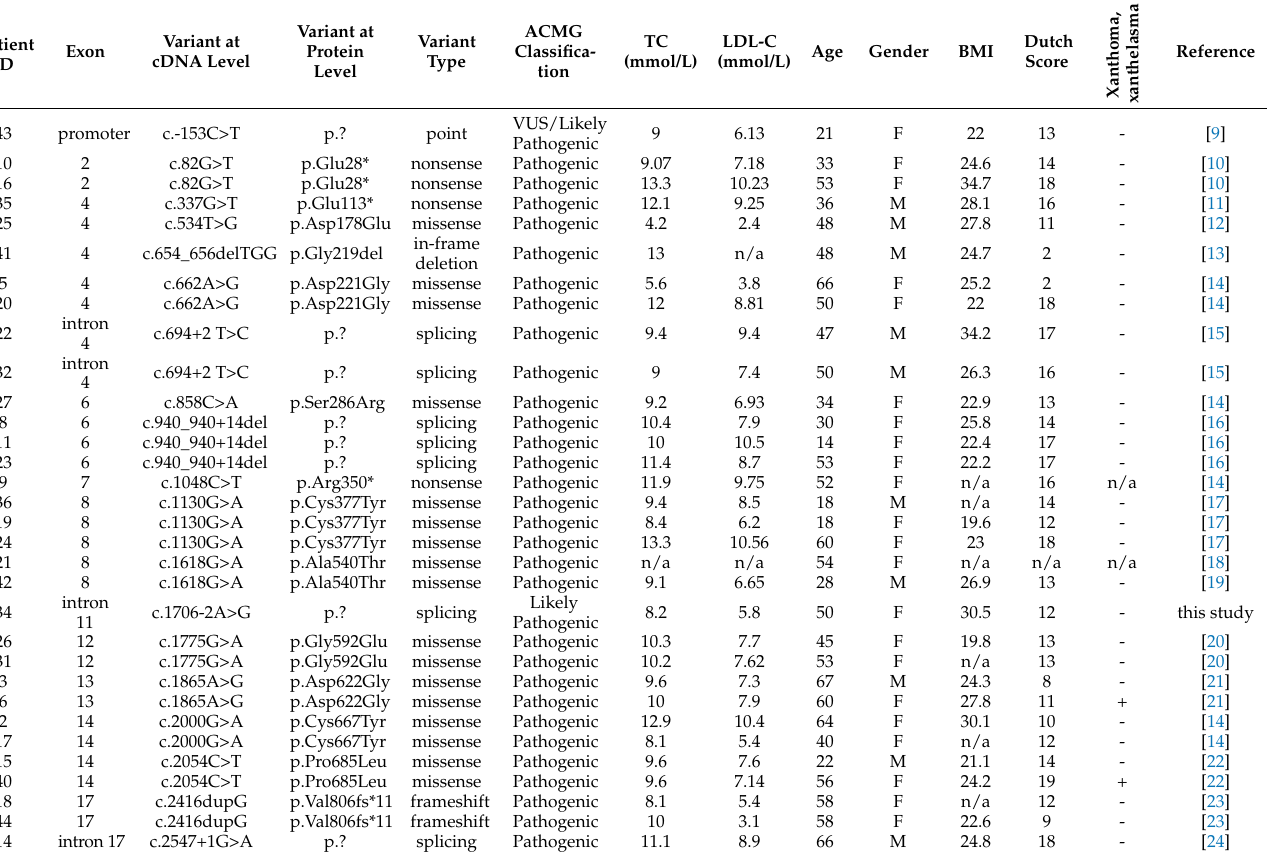
Table 2. Clinical and phenotypic data on Hungarian patients with LDLR variants and detailed summary of LDLR variants—patients with small-scale LDLR